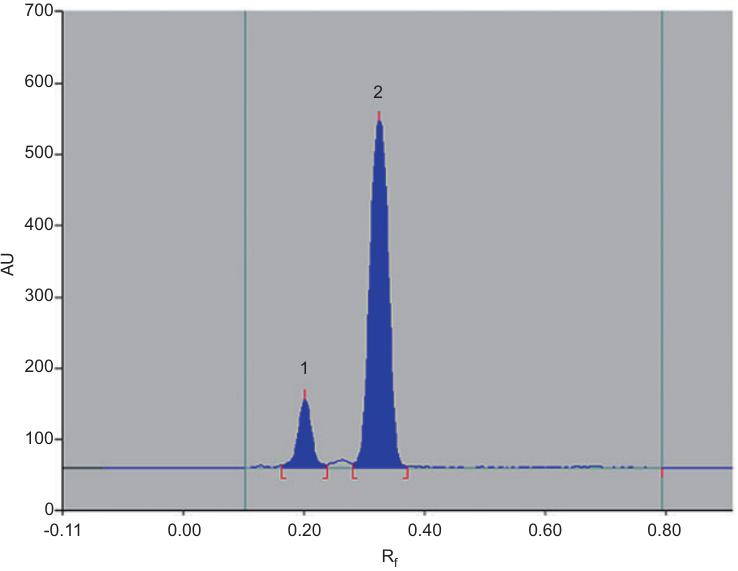
Figure 3 Densitogram of ethinyl estradiol, R Concentration of drugs: 200 µ g/ml of ethinyl estradiol and 200 µ g/ml of drospirenone. Application volume: 10 µ